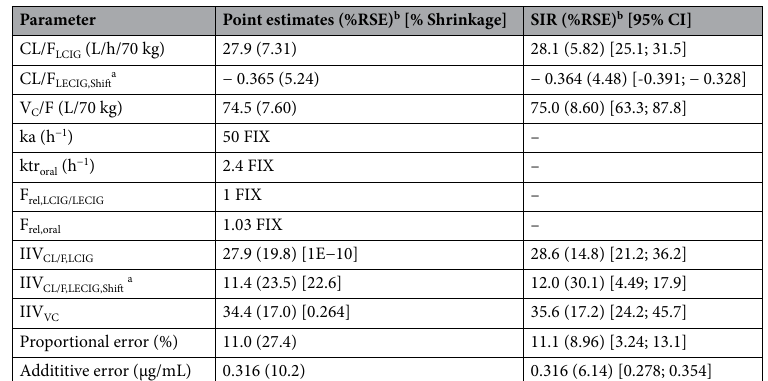
Table 2. Parameter estimates for the final population pharmacokinetic model of LCIG and LECIG, and results from the SIR evaluation. a Shift in CL/F for LECIG, CL / F i = TVCL / F LCIG × e CL , LCIG × (cid:31) Weight 70 (cid:30) × e CL , LECIG , Shift 1 + TVCL . b NONMEM point estimate and the associated % relative standard error LECIG , Shift (cid:31) (cid:30) (% RSE, reported on the approximate standard deviation scale (SE/variance estimate)/2). CI, confidence interval; IIV, inter-individual variability (CV%). SIR, sampling importance resampling.